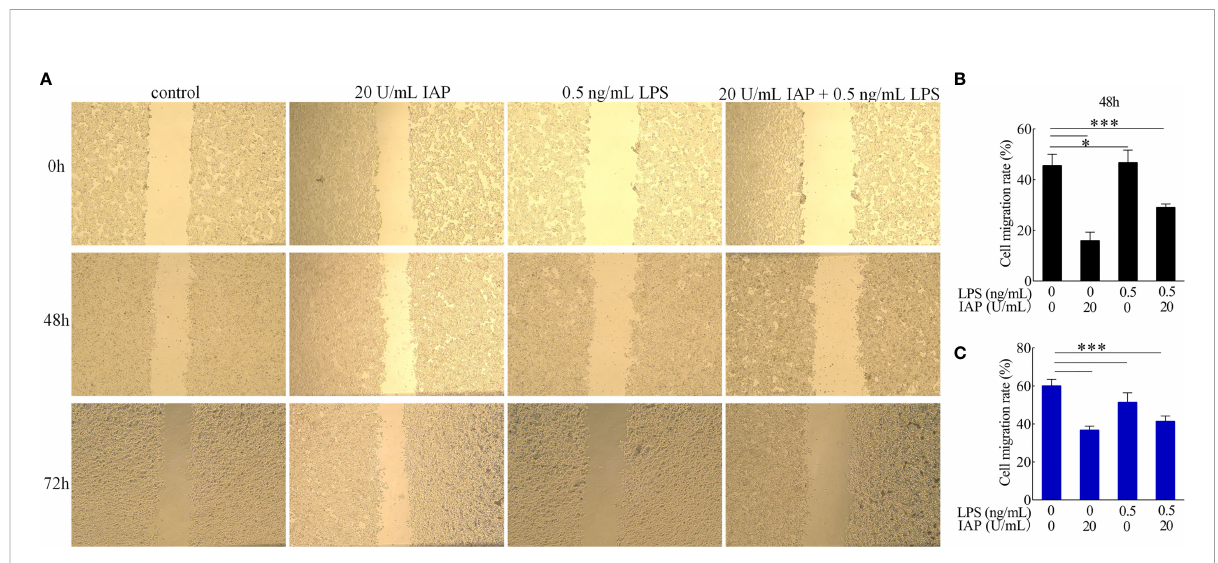
FIGURE 7 Effect of IAP on LPS-induced (A) cell migration and cell migration rate of (B) 48 and (C) 72 h in cocultured HT-29 cells + freshly extracted human leucocytes. Images was obtained by an OLYMPUS inverted microscope (×20). Values are presented as means ± SD (n = 3/group). Analysis of variance with Tukey. *P < 0.05; ***P < 0.001.